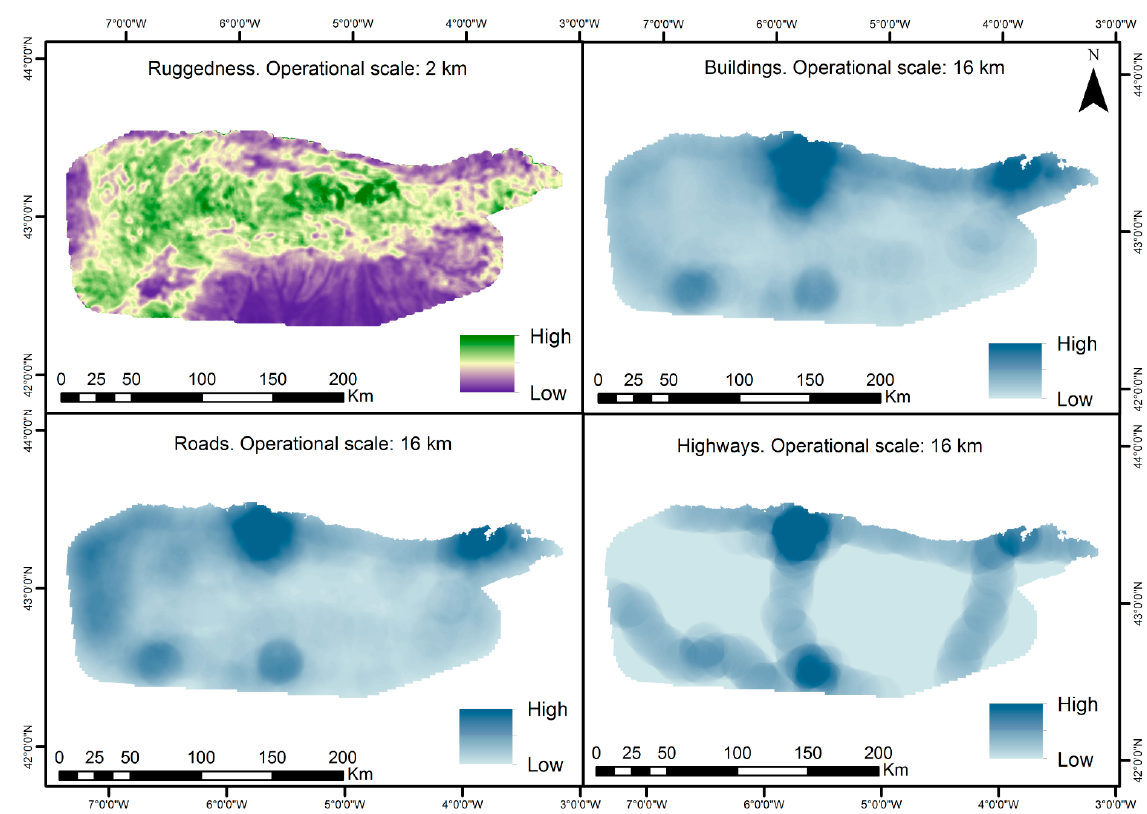
Figure A2. Operational scales of the forest area variable for the three datasets.